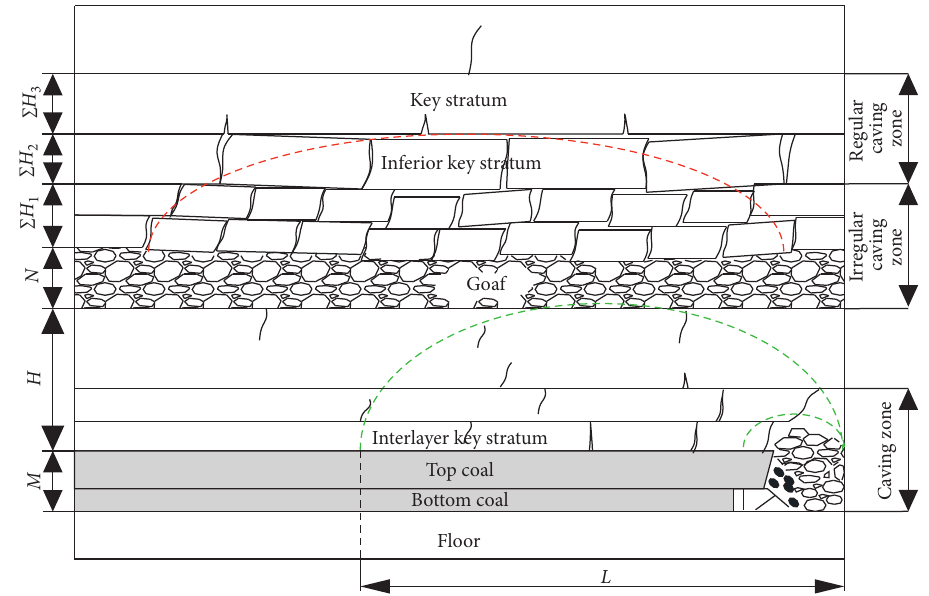
Figure 6: Stability of arch structure under the condition of proximate roof coal interlayer key